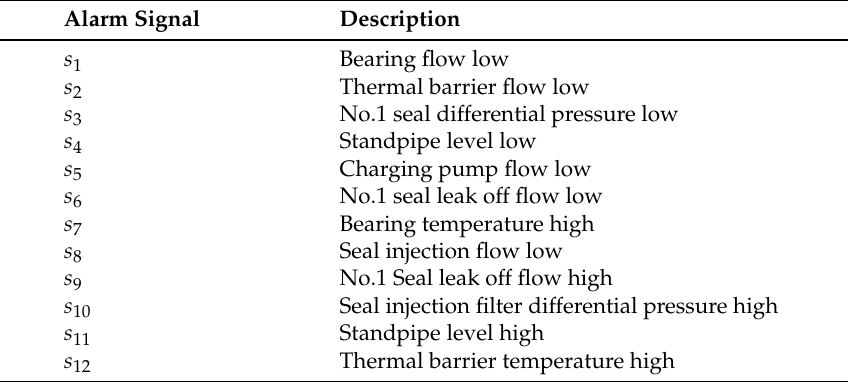
Table 1. Alarming signals sensors of